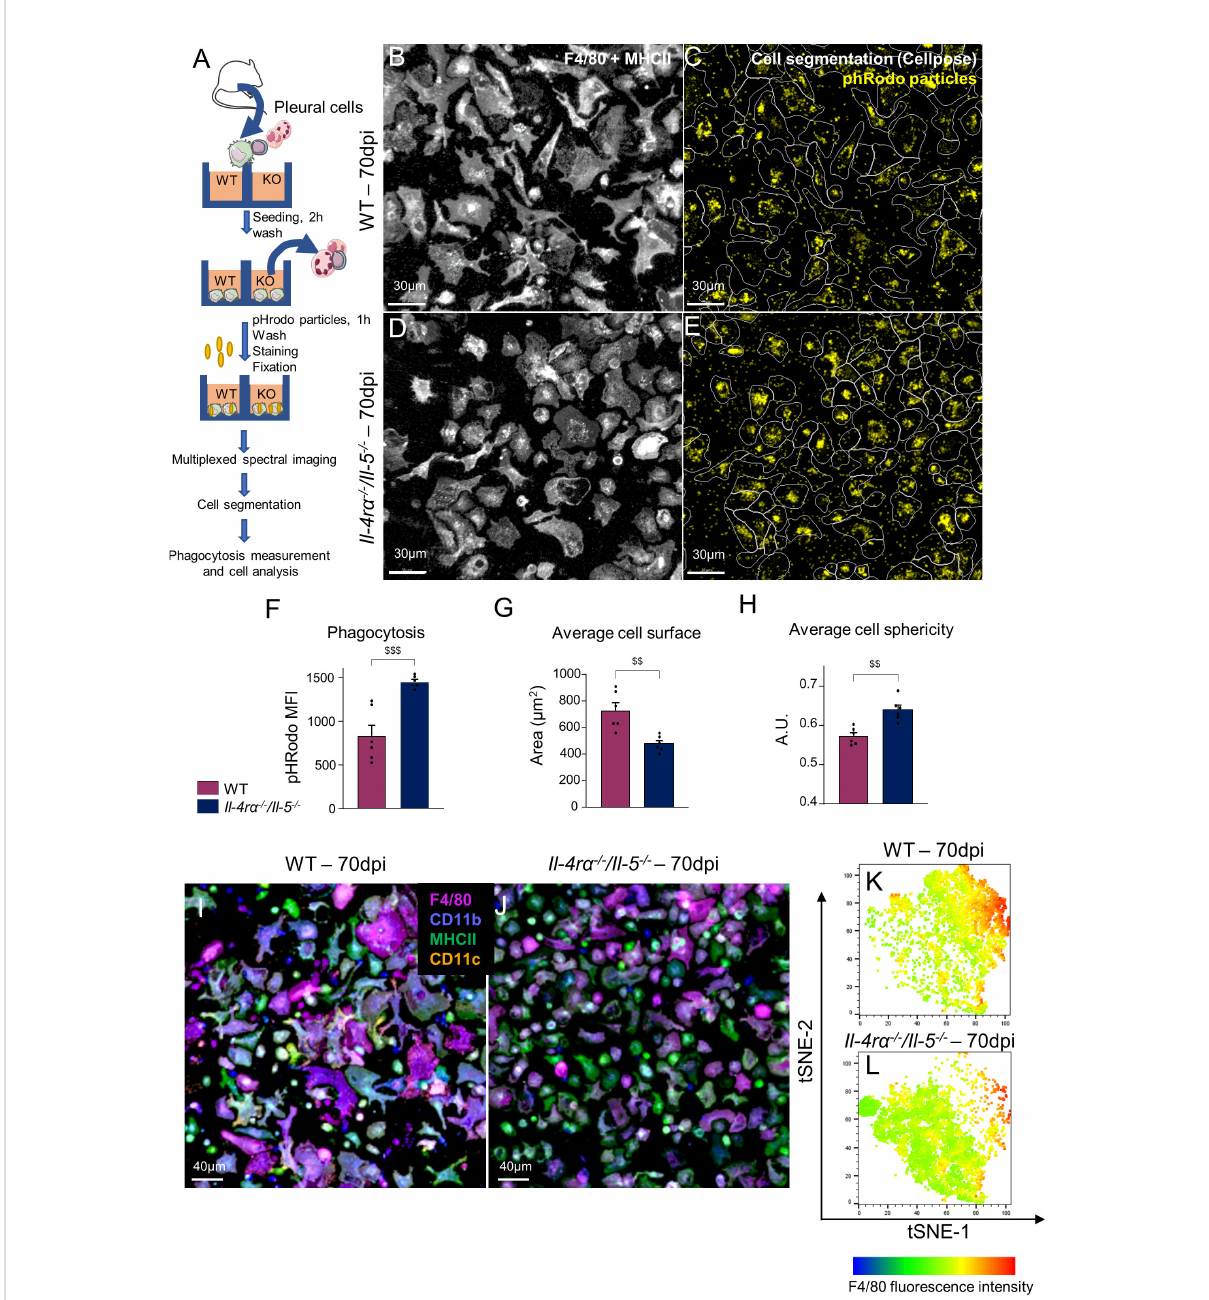
FIGURE 3 Pleural macrophages from Th2-de fi cient mice present higher phagocytic capacity but lower phenotypic diversity. Pleural macrophages from L. sigmodontis infected wild-type (WT) and Il-4r a -/- /Il-5 -/- BALB/c mice were cultured with E. coli fl uorescent bioparticles to address their phagocytic capabilities by confocal multiplex imaging. (A) Diagram of the experimental setup. (B, D) Aspect of the F4/80 + and/or MHCII + adherent pleural cells from infected (B) WT and (D) Il-4r a -/- /Il-5 -/- BALB/c mice. (C, E) Cellpose algorithm (45) cell segmentation outline (while line) and phRodo fl uorescence signal (yellow) in infected (B) WT and (D) Il-4r a -/- /Il-5 -/- BALB/c mice. (F) Phagocytosis expressed as phRodo mean fl uorescence intensity (MFI). (G) Measure of the average cell surface. (H) Measure of the average cell roundness. (I, J) Multiplex images of adherent pleural macrophages from (I) WT and (J) Il-4r a -/- /Il-5 -/- mice showing expression of F4/80 (purple), CD11b (blue), MHCII (green) and CD11c (orange). (K, L) tSNE analysis of single cell fl uorescence intensity and shape parameters extracted from cell segmentation of microscopy images. Dots represent individual mice and results are expressed as mean ± SEM of n = 6 mice per group. For the tSNE analysis, at least 600 F4/80 + cells per mouse were concatenated. A t-test was performed (data normally distributed) $$ p<0.01 and $$$ p<0.001 represent differences between WT and Il-4r a -/- /Il-5 -/-